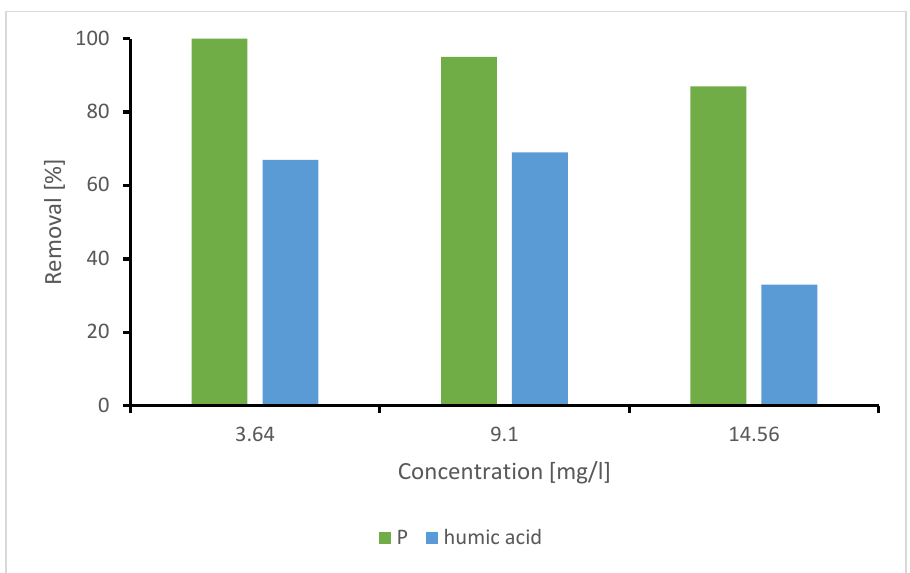
Figure 6. Effects of humic acid presence on phosphorus removal (adsorbent dose = 1 g/L, agitation speed = 200 rpm, temperature = 20 °C, contact time = 60 min).